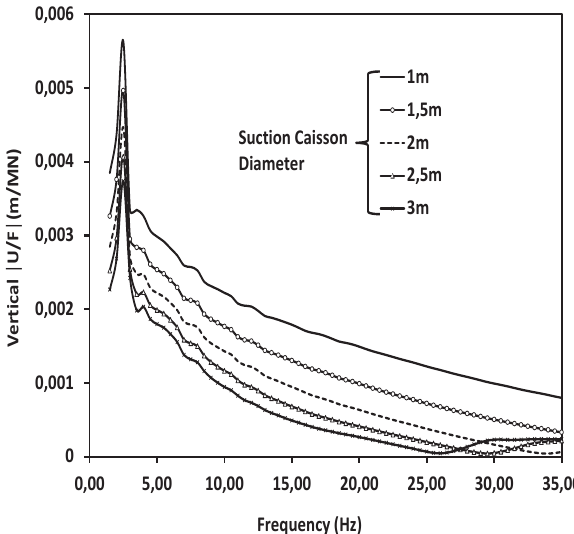
Figure 7 Vertical displacement amplitude │U/F│̶ Figure 7: Vertical displacement amplitude │ U/F │